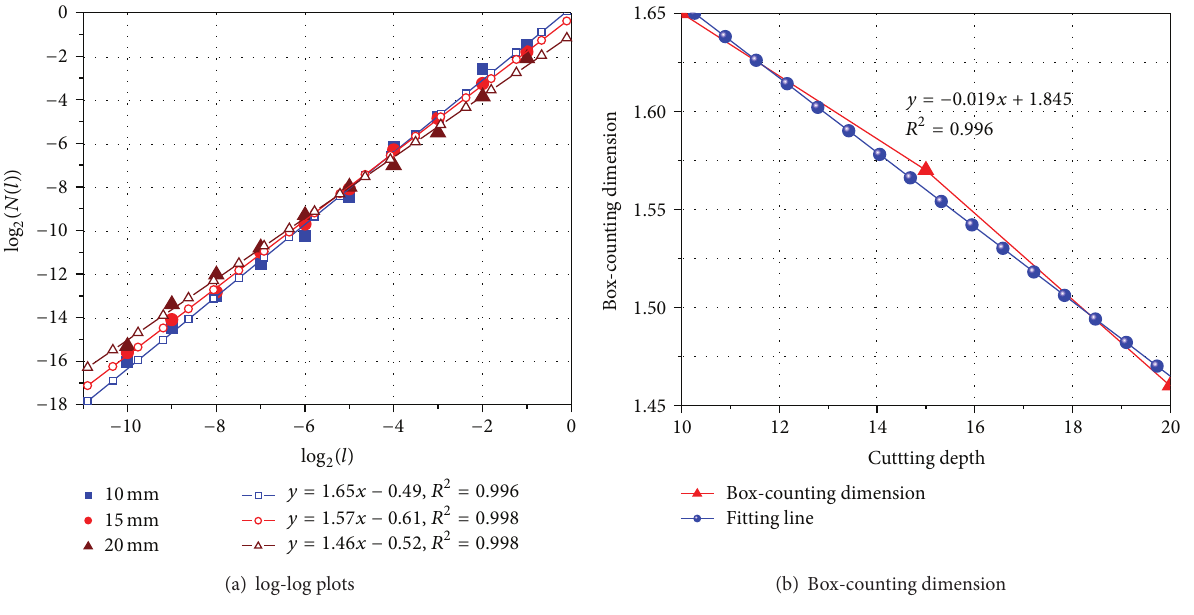
Figure 8: Box-counting dimension of cutting load under different cutting depths.